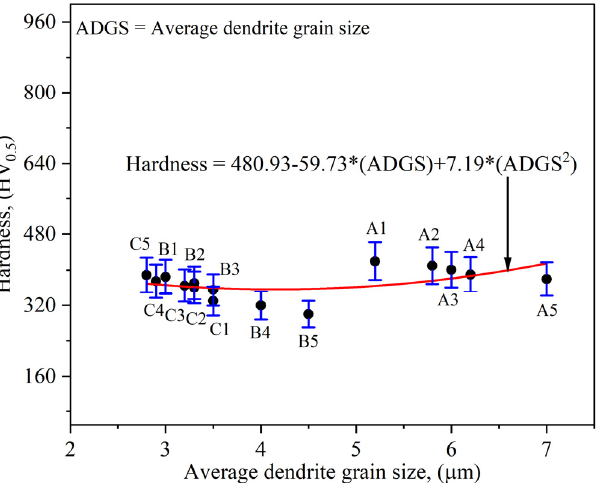
Figure 15. Relationship between average dendrite grain size and hardness value.